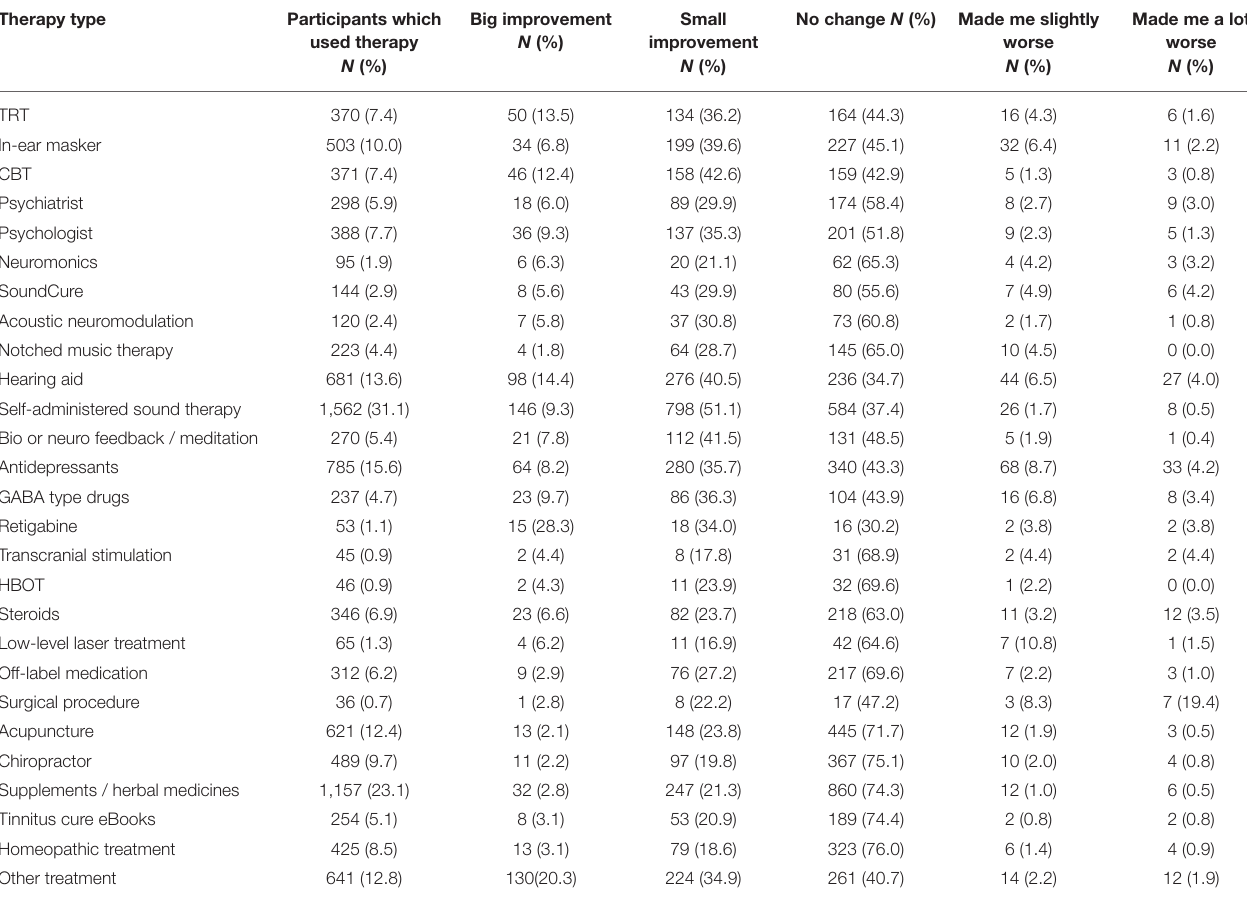
TABLE 2 | Numbers of participants which underwent a treatment out of survey “Causes and Treatment” ( n = 5,017) with outcomes per treatment [numbers according to scored outcome per treatment and